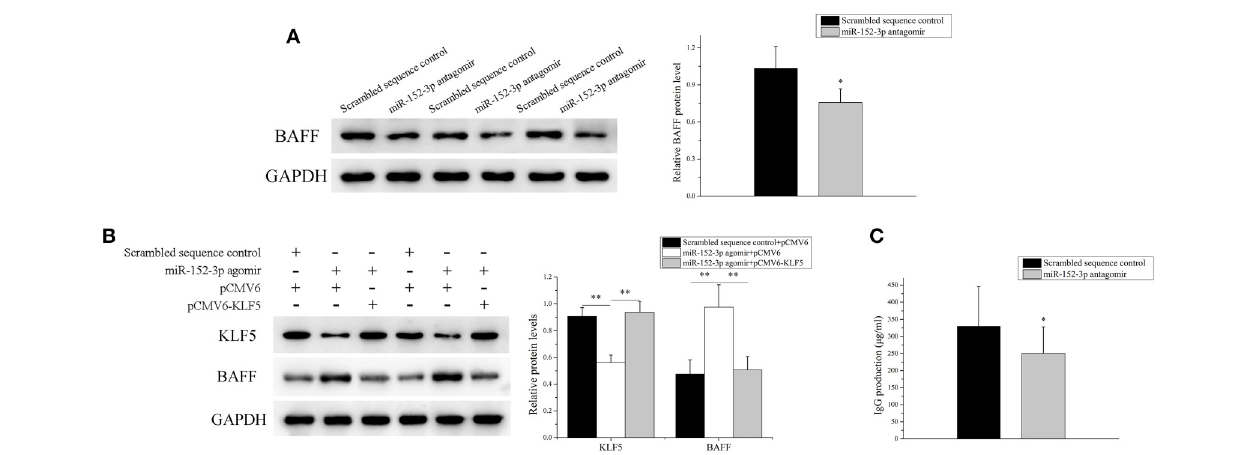
FIGURE 6 | Knockdown of miR-152-3p expression alleviated the BAFF expression in SLE B-cells. (A) The BAFF protein level in SLE B-cells transfected with miR-152-3p antagomir or scrambled sequence control was assessed by Western blot analysis. One representative blot is shown (left panel). The intensity of the bands was semi-quantitated and normalized to GAPDH (right panel). All experiments were performed in triplicate. The variables were compared using the paired t -test. (B) KLF5 and BAFF protein levels in healthy control B-cells after miR-152-3p agomir and pCMV6 or pCMV6-KLF5 co-transfection. One representative blot is shown (left panel). The intensity of the bands was semi-quantitated and normalized to GAPDH (right panel). All experiments were performed in triplicate. The variables were compared using the ANOVA test (C) SLE B-cells transfected with miR-152-3p antagomir or scrambled sequence control, where the transfected cells were co-cultured with purified autologous CD4 + T-cells. The IgG levels in the culture supernatants were measured using ELISA. Data represent the mean of three independent experiments per group. The variables were compared using the paired t- test. * P < 0.05 and ** P <